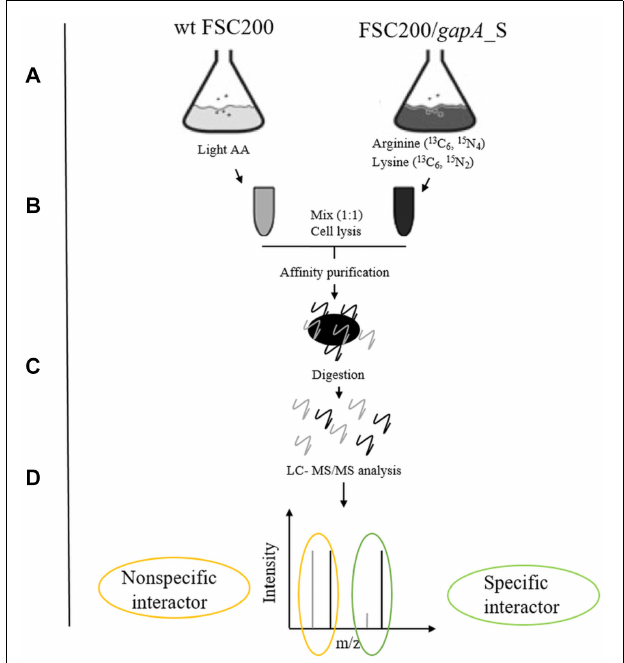
FIGURE 1 | Schematic overview of SILAC-AP-MS/MS strategy. (A) The bacterial strains wt FSC200 and FSC200/ gapA_ S were grown in CDM with light or heavy amino acids (arginine 13 C 6 , 15 N 4 ; lysine 13 C 6 , 15 N 2 ). (B) Bacterial cultures (OD 600 nm = 0.8) were mixed in 1:1 cell ratio and lysed by French press. (C) GapA/S together with interacting partners was purified using Strep-tag R (cid:13) purification system and digested with trypsin. (D) Tryptic peptides were analyzed by